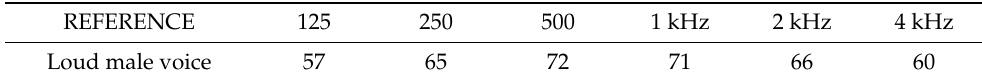
Table 5. Frequency data used for sound source